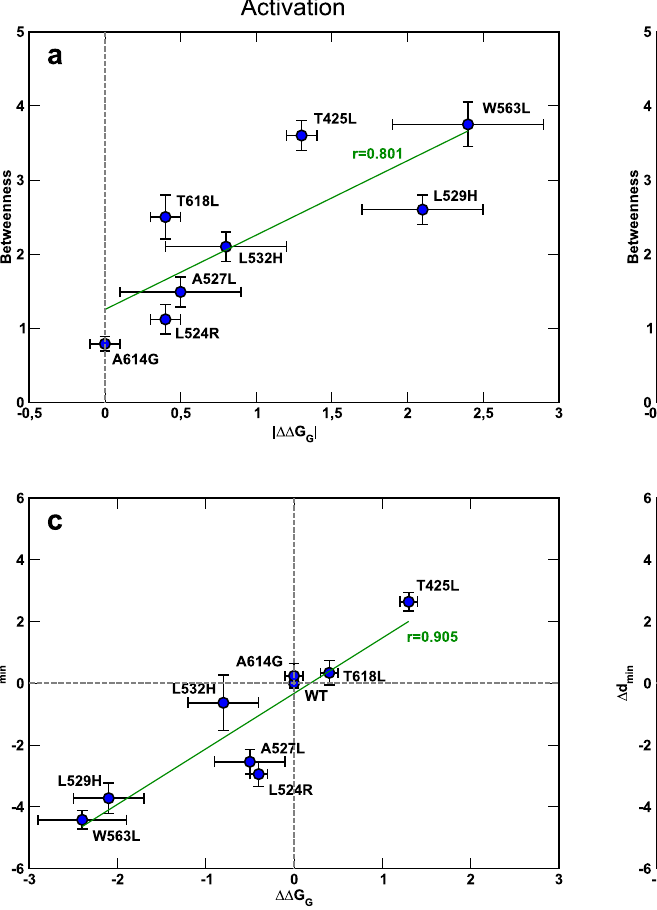
Fig.5|ScatterplotscomparingthebetweennesscentralityofWTresiduesand the average minimal path length variation ( Δ d min =d minMUT — d minWT , see Methods for the de fi nition of d min ) of mutants with respect to WT residues along the noncanonical paths against the free-energy perturbation of activa- tion ( ΔΔ G G ) and of inactivation ( ΔΔ G I ). Panels a and b refer to betweenness centrality vs| ΔΔ G G |and betweenness centrality vs| ΔΔ G I |, respectively. Panels c and d refer to Δ d min vs ΔΔ G G and Δ d min vs ΔΔ G I , respectively. Green lines are linear fi ts to the data computed by the regression analysis derived by n =8 inde- pendentsamples(i.e.,pointsineachpanel)and “ r ”